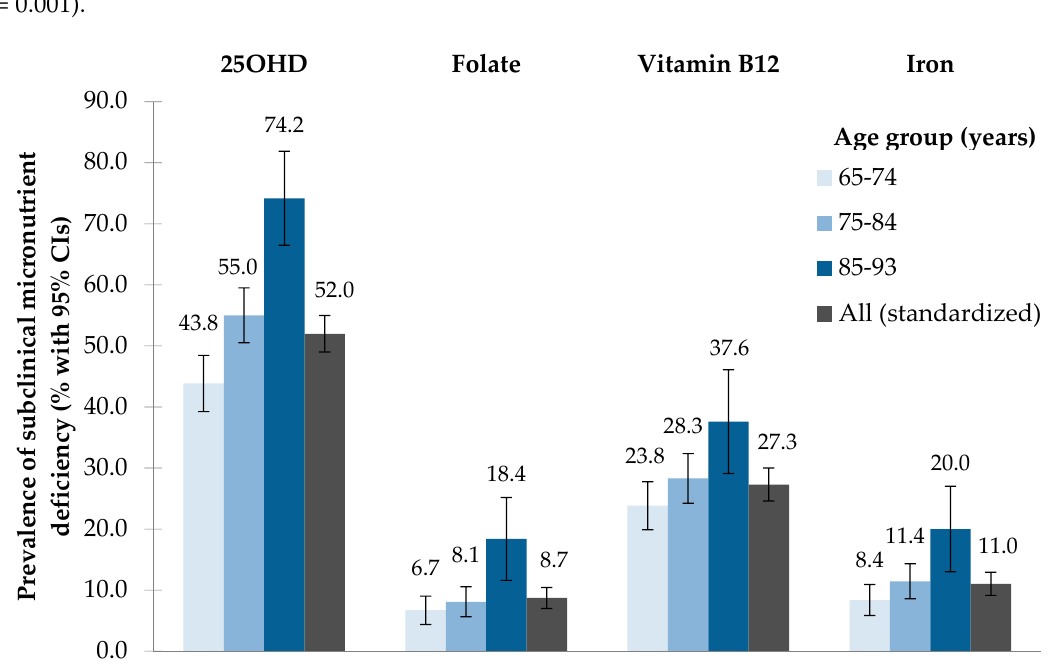
Figure 1. Prevalence of subclinical micronutrient deficiencies by age groups, based on serum biomarkers in KORA-Age 2008/2009 (25OHD = 25-hydroxyvitamin D; CI = confidence